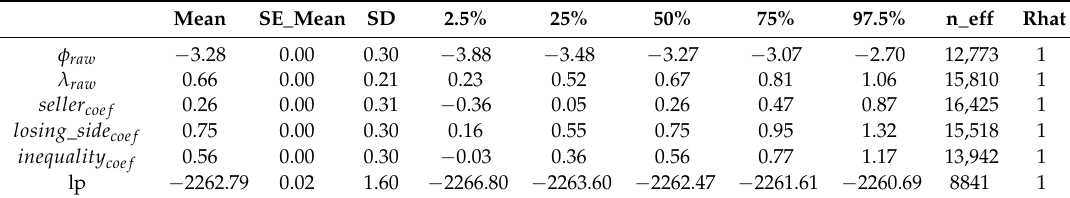
Table 3. Estimation